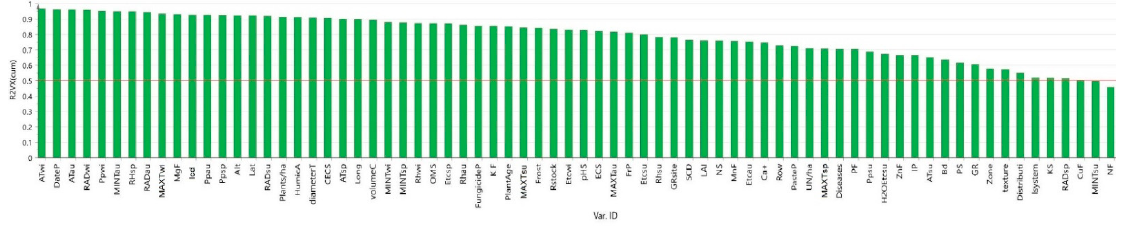
Figure 2. Weight plot of the PCA variables associated with the incidence of branch canker and dieback in Chilean orchards prospected in this study in the 2014 and 2015 seasons, including 16 orchards and 76 variables. R 2 VX: fraction of independent variance explained for every variable X. Red line shows the limit criteria for explained variance (R 2 VX ≤ 0.5). PCA of scenario 1. The PCA performed included data analysis of both growing sea- sons (2014 and 2015). This analysis indicated that the multifactorial model retained two components that explained 77.9% of the total variance. Factor 1 explained 62.4% of the total variance, while Factor 2 explained 15.6% of the total variance. In the score and load- ing plots, Factor 1 sorted the orchards on the left side according to their high values of